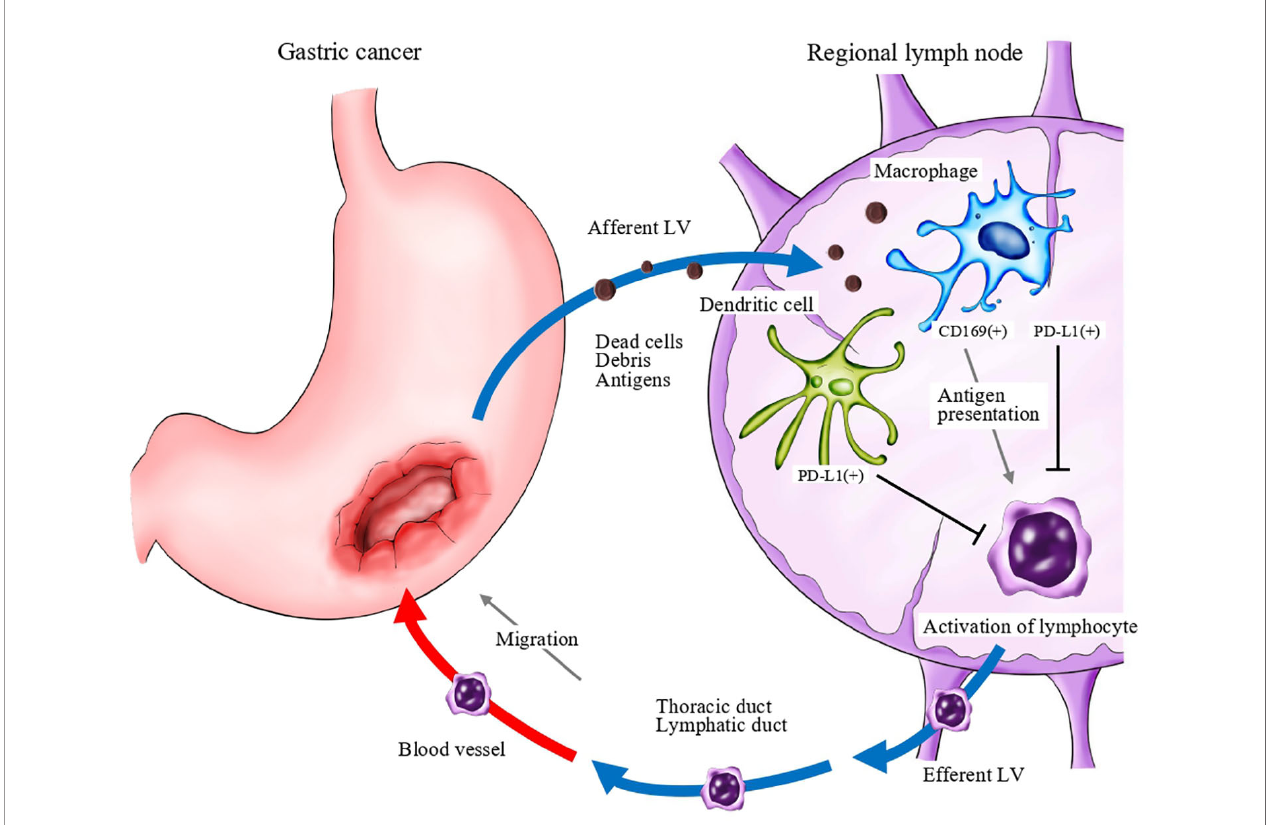
FIGURE 8 | A schema of the anti-cancer immune response associated with regional lymph nodes. Dead cells and debris, including tumor-speci fi c antigens, drain into lymph node sinuses via lymphatic vessels (LV). Antigen-presenting cells, such as macrophages and dendritic cells, capture and engulf these antigens and activate antigen-reactive T lymphocytes. Programmed death ligand 1 (PD-L1; and potentially PD-L2) expressed on antigen-presenting cells may negatively regulate the activation of T